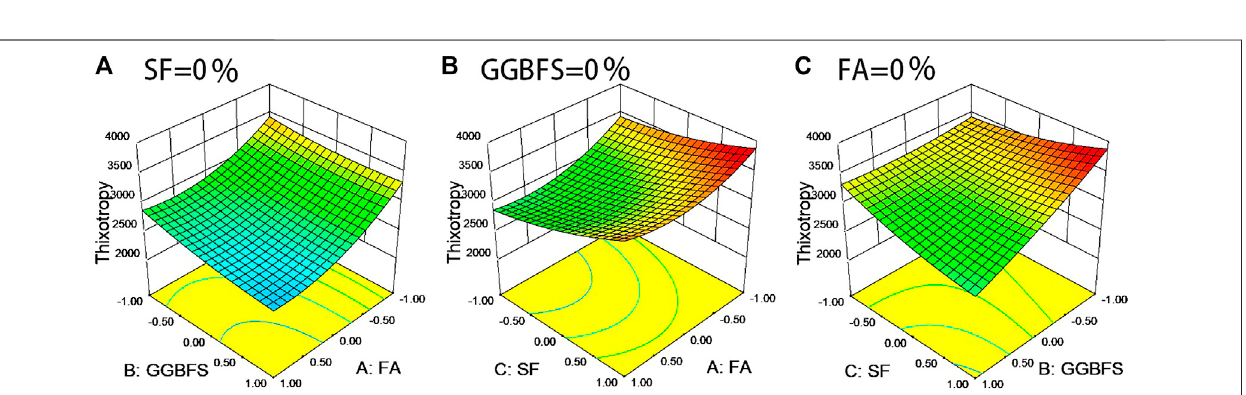
Frontiers in Materials |